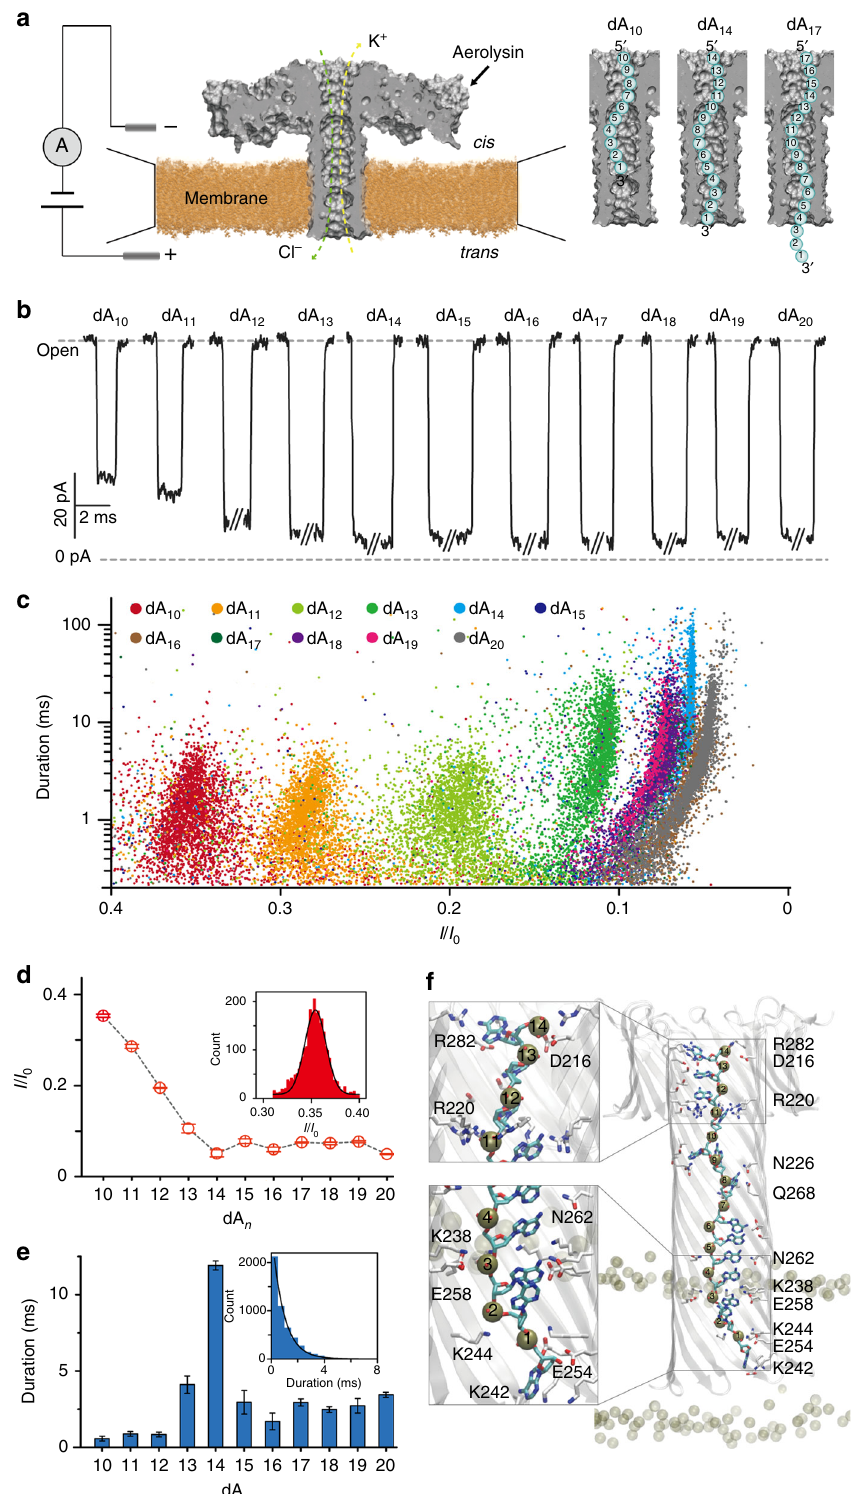
Fig. 1 Single-channel recording of dA n ( n = 10 – 20) with aerolysin nanopores. a Schematic representation of the aerolysin nanopore system, and dA n (cyan circles) of different lengths transported through it (only the pore lumen is shown for the sake of clarity). Typical current traces ( b ), scatter plots ( c ), statistical analysis of I/I 0 ( d ), and corresponding durations ( e ) caused by different lengths of dA n ( n = 10 – 20) using aerolysin nanopores. All data were obtained in 1.0 M KCl, 10 mM Tris, and 1.0 mM EDTA, pH = 8.0, 24 ± 2 °C at the bias potential of + 140 mV. The errors of the data were based on at least fi ve separate measurements. f MD snapshot of dA 14 fully inserted in the pore. The molecules are colored as follows: nitrogen blue, oxygen red, carbon cyan (for DNA) or white (for protein), and phosphate tan. The membrane and DNA phosphate atoms are shown as spheres. The dA 14 nucleotides are numbered according to the text. The insets show the most important interactions. The image was created with the Visualization Molecular Dynamics (VMD) software